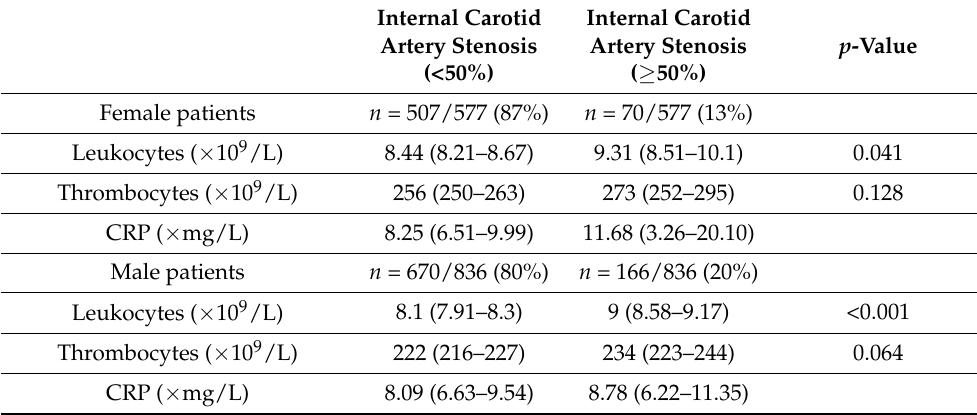
Table 2. Serum markers in patients with and without internal carotid artery stenosis. Internal Carotid Artery Stenosis